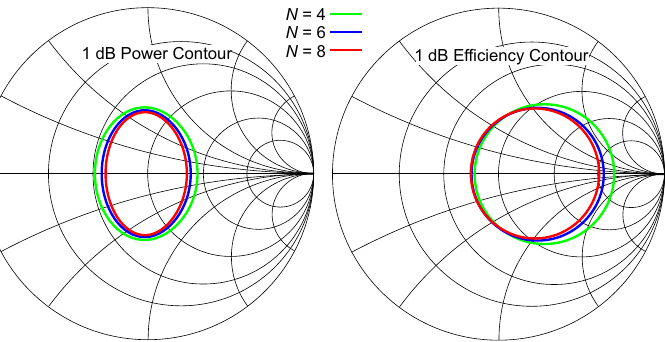
Figure 2. Power and efficiency 1dB contours for device modeled using the N -model, on a Smith Chart normalized to R opt , for different values of N .